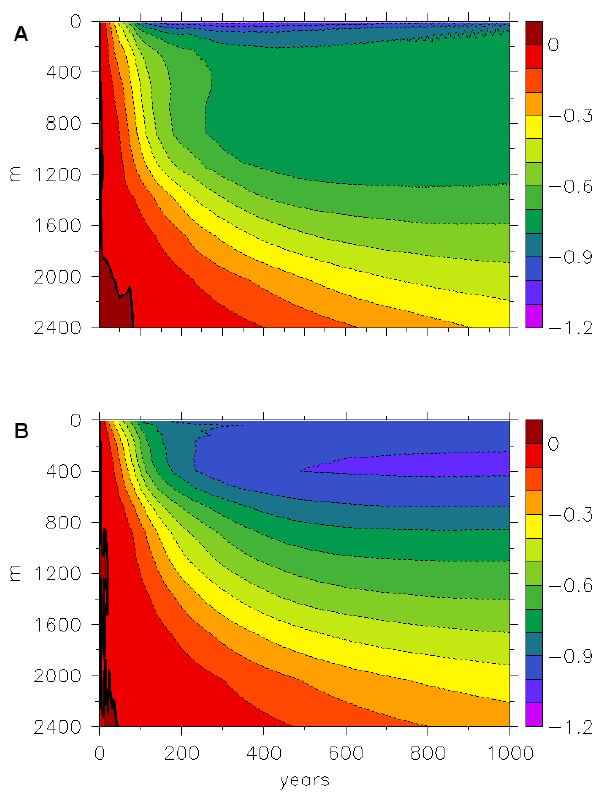
Fig. 9. Potential density anomaly (kgm − 3 ) for linearly increasing CO 2 concentration (to 1120 ppm within 100 yr): (A) average of northern area, (B) average of central area.